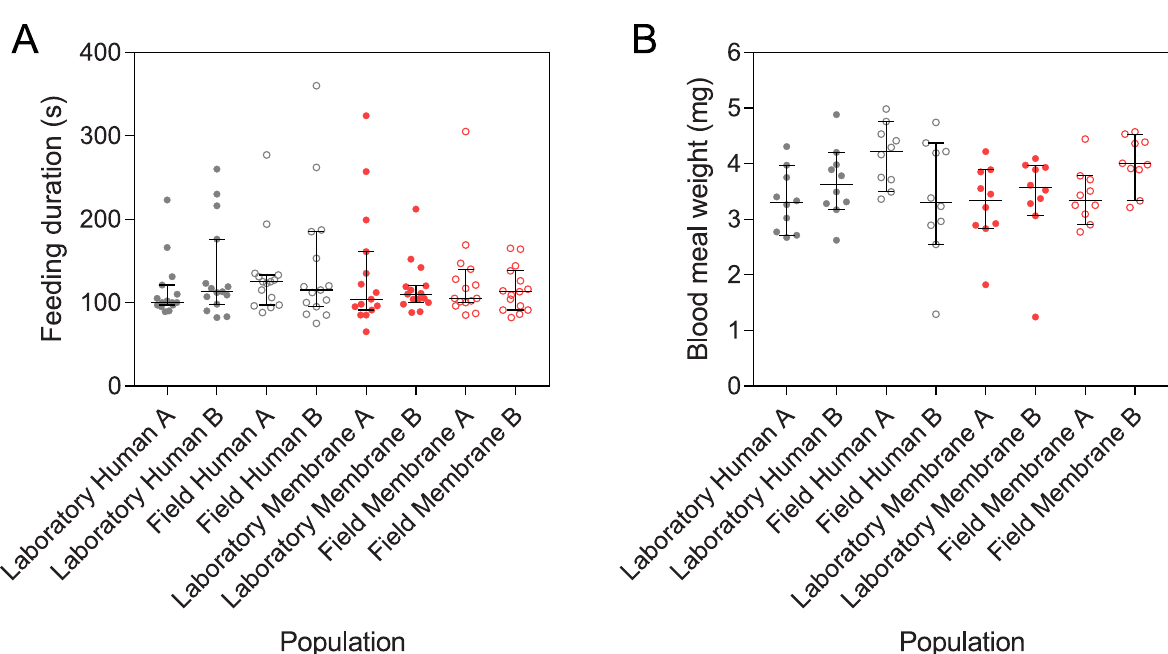
Fig 3. Feeding duration (A) and blood meal weight (B) of membrane- and human-selected Aedes aegypti populations when females were fed on a human volunteer. Bars are medians with 95% confidence intervals.